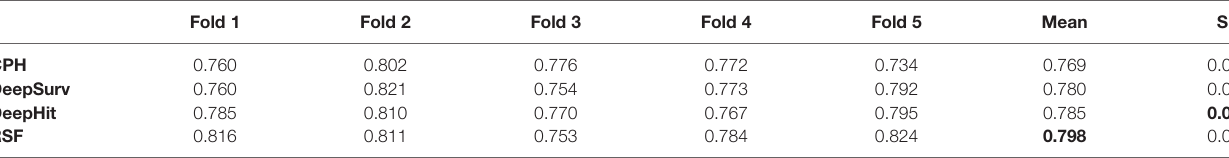
TABLE 2 | C-index for